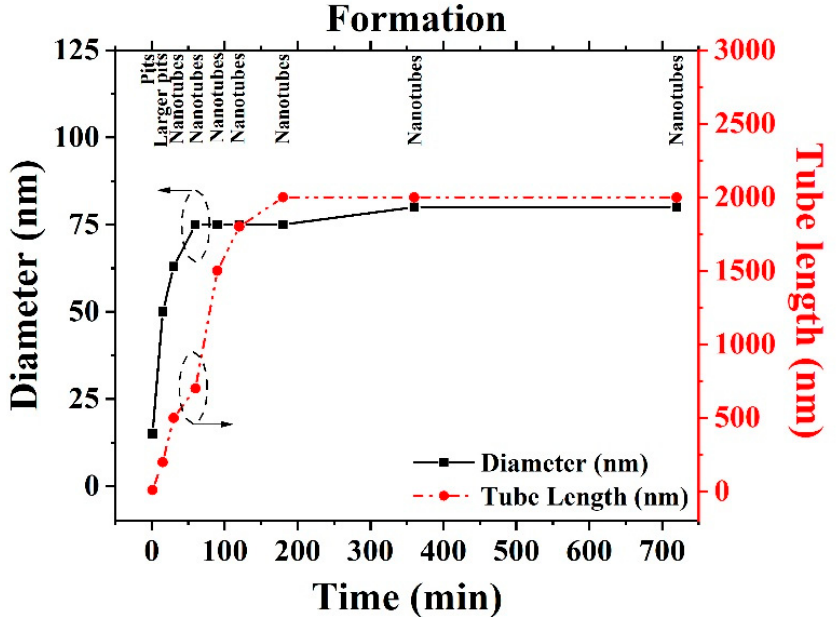
Figure 6. Titanium–dioxide (TiO 2 ) nanotube (TNT) features formed (NH 4 F = 0.5 wt.%, voltage = 20 V) for 1, 15, 30, 60, 90, 120, 180, 360, and 720 min. All anodization was performed at 20 V in glycerol-water added to it 0.5 wt.% NH 4